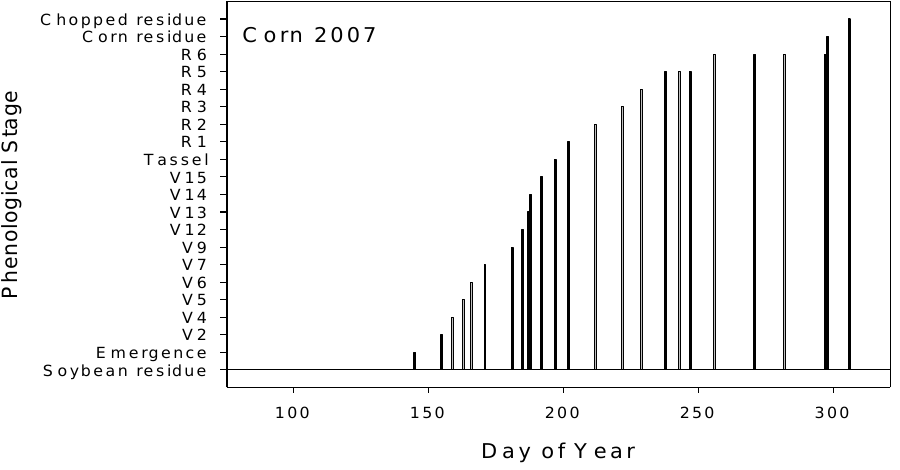
Figure 3. Sequence of agronomic practices and phenological [24]stages of the corn crop for the 2007 cropping season.